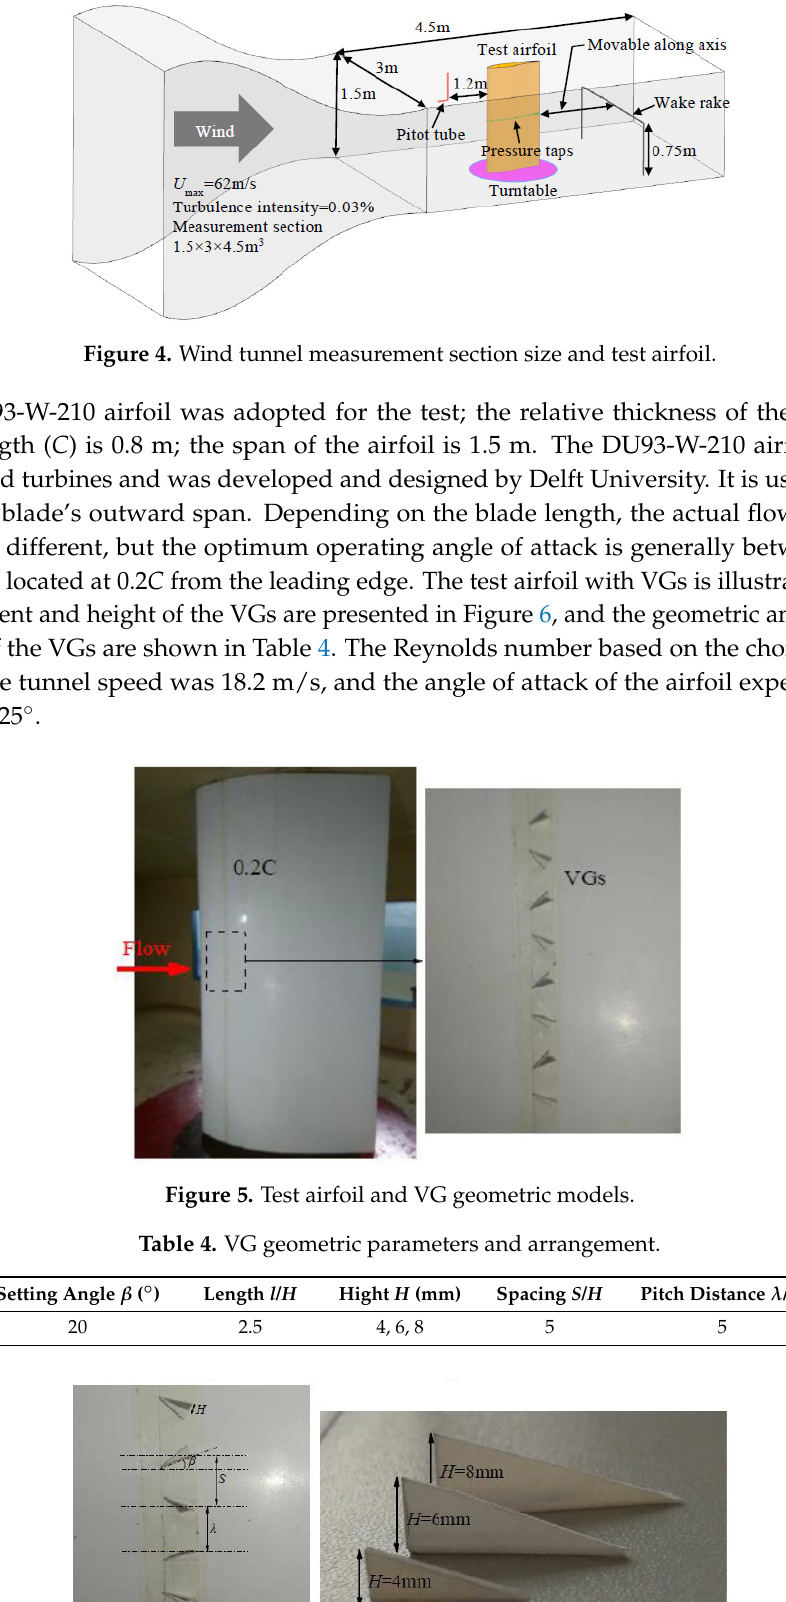
Figure 4. Wind tunnel measurement section size and test airfoil.